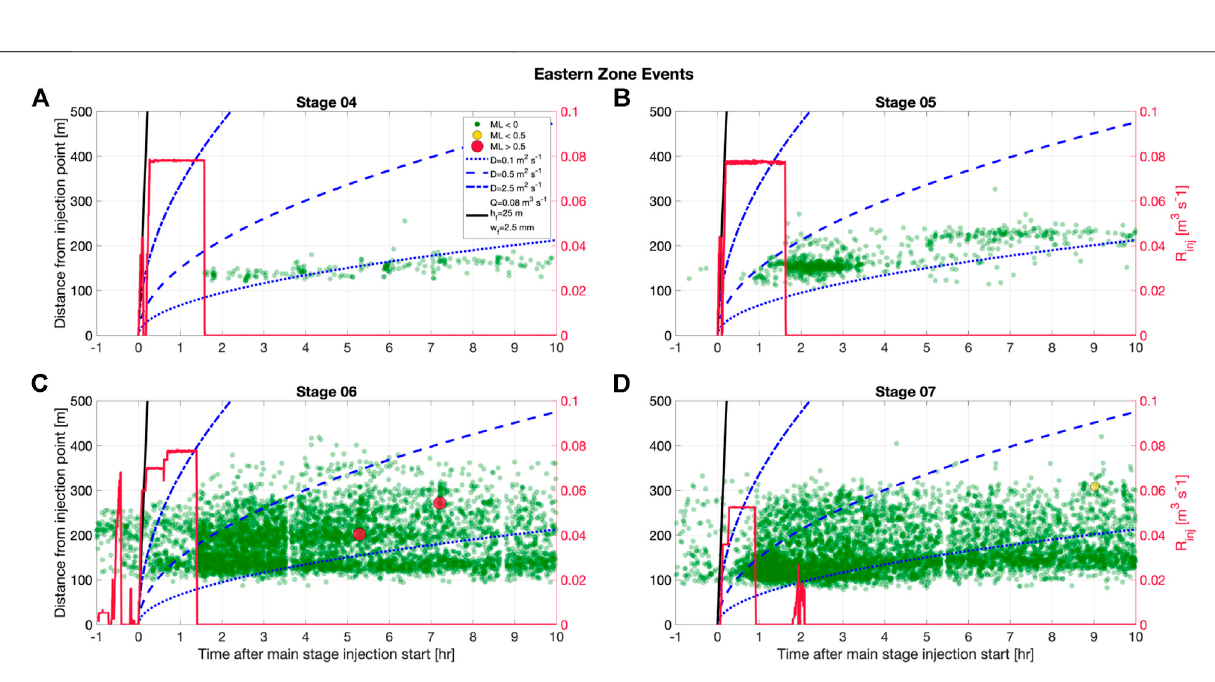
Frontiers in Earth Science |